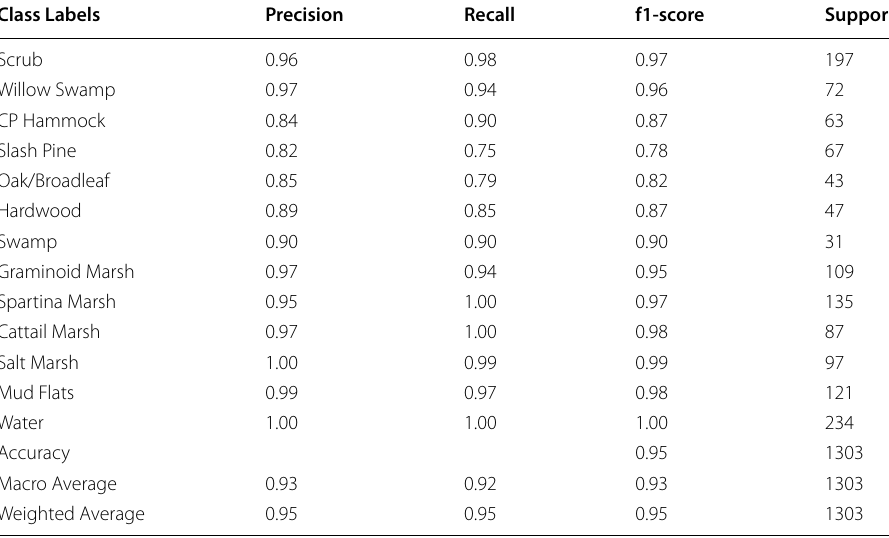
Table 15 Detailed classification test results for the Kennedy Space Center Dataset in terms of Precision, Recall, and F1-Score. Testing was done with PCA 30 CEU-Net no-patching with a 75%/25% Training/Testing split